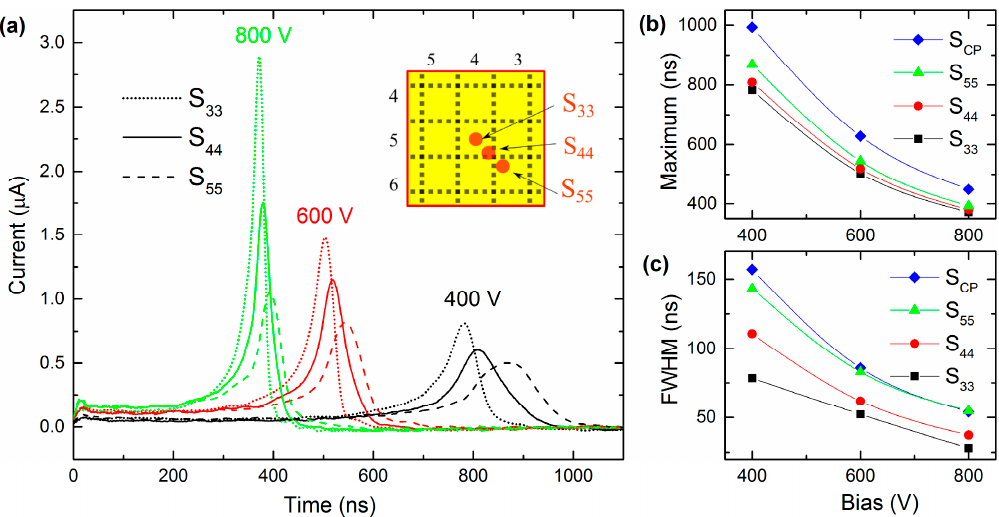
Figure 5. Bias dependence of ( a ) total current waveforms measured by illuminating S 33 , S 44 , and S 55 spots, ( b ) waveform maxima, and ( c ) peak full width at half maximum (FWHM). Lines S CP show results evaluated in unguarded pixel measurements defined in Section 3.1.